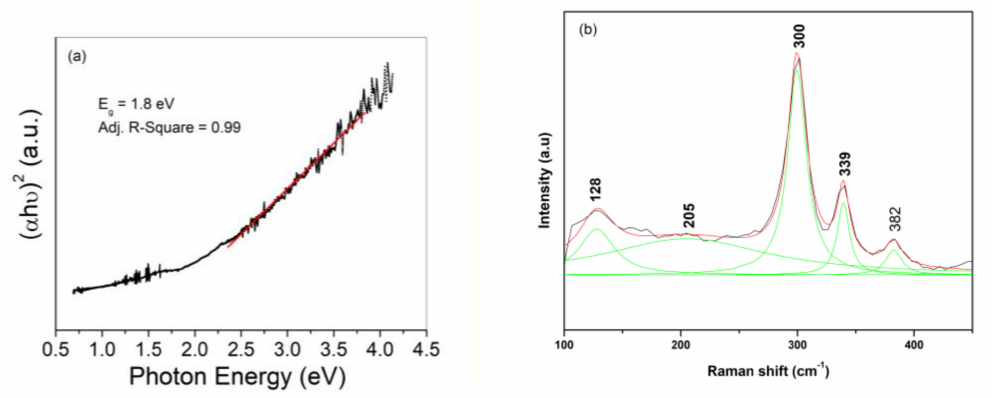
Figure 3. ( a ) Representative plot of diffuse reflectance against photon energy ( h ν ) for CuCr 1 . 0 Sn 1 . 0 S 2 . 3 Se 1 . 7 sample. Red line is included to show the baseline, and linear extrapola- tion used to determine the band gap. ( b ) Representative Raman spectral of CuCr 1 . 6 Sn 0 . 4 S 2 . 3 Se 1 . 7 powder sample with the different contributions deduced from the fitting of the different peaks with Lorentzian curves (green